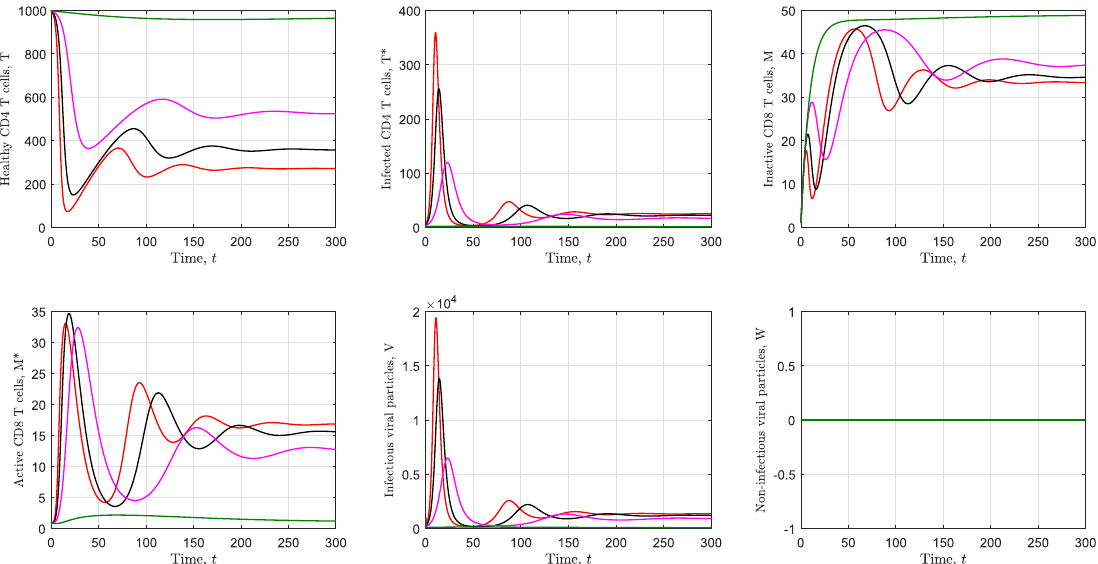
Figure 4. Dynamics of the model (7), fixed values are used for the CD4 T cell infection probability, β = 2.5 × 10 − 5 , the probability of the active CD8 T cells eliminating the infected CD4 T cells, γ = 2 × 10 − 3 , and no use of PI is considered, u 2 = 0. The RTI are varied, thus u 1 = ( 0.2,0.4,0.6,0.8 ) , corresponding to the colored curves (red, black, magenta, and green) with their respective values of R 0 = ( 1.6224,1.3168,1.0112,0.7056 ) . Simulations were performed in the interval of 300 days.